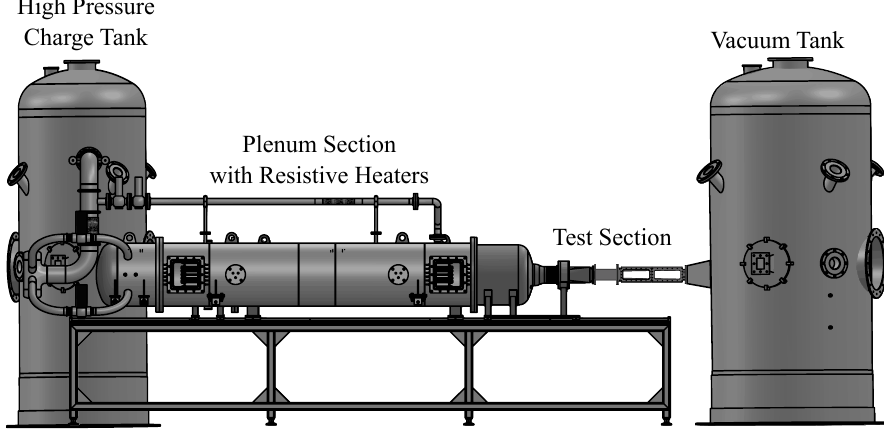
Figure 2. Overview of the SBR-50 facility with major components